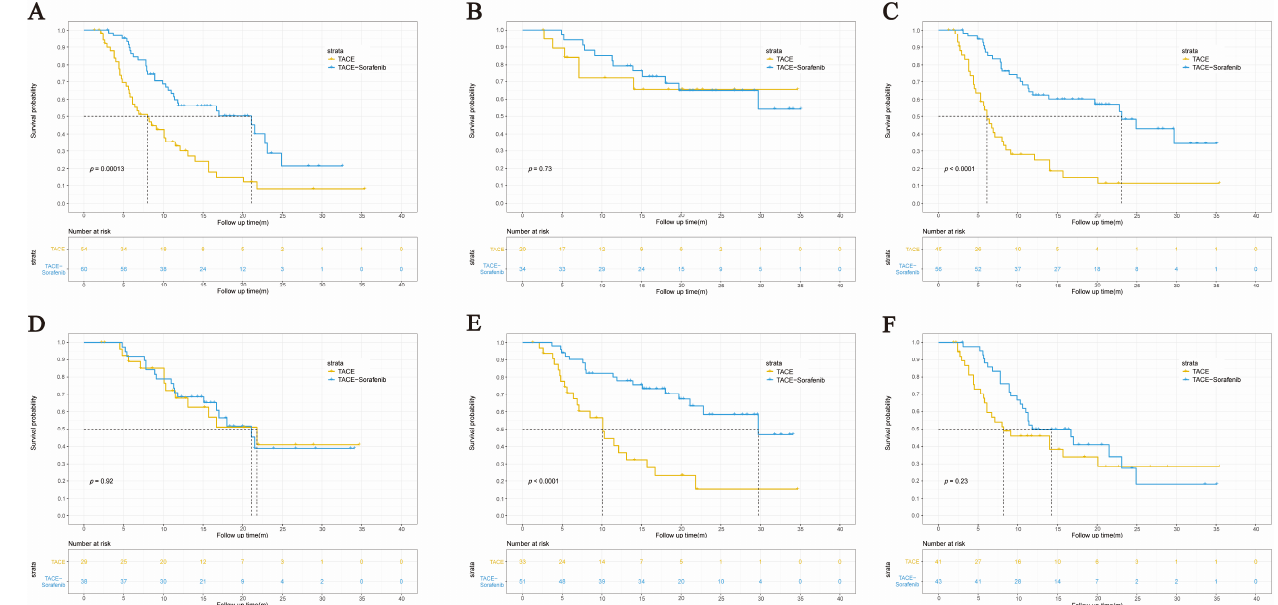
Figure 5. Potential factors for predicting the benefits from sorafenib after TACE administration. ( A ) High VEGF and ( B ) low VEGF ( p for interaction = 0.233). ( C ) Tumor size > 7 cm and ( D ) tumor size ≤ 7 cm ( p for interaction = 0.004). ( E ) Low total bilirubin and ( F ) high total bilirubin ( p for interaction = 0.031).